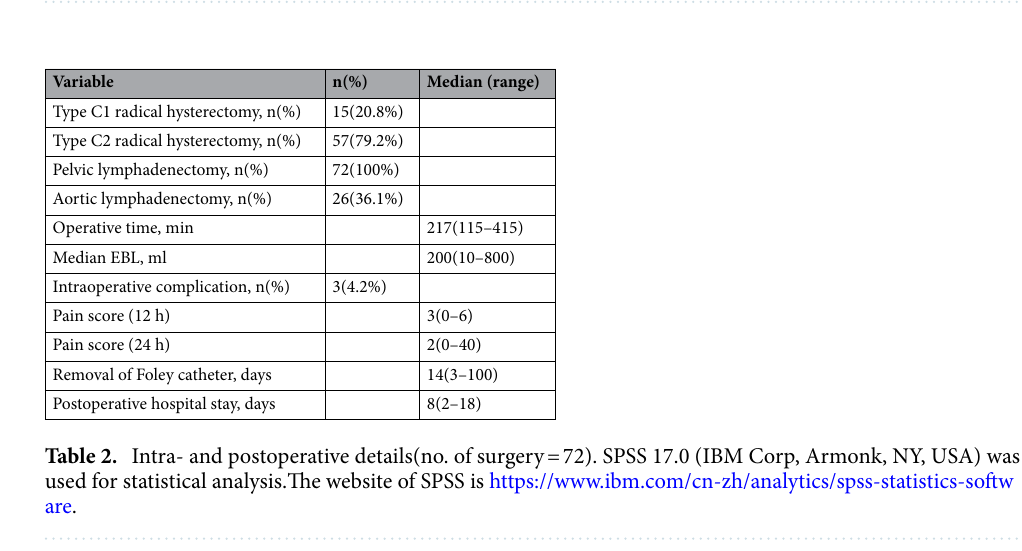
Table 1. Patients’ characteristics and staging (no. of surgery = 72). SPSS 17.0 (IBM Corp, Armonk, NY, USA) was used for statistical analysis.The website of SPSS is https:// www. ibm. com/ cn- zh/ analy tics/ spss- stati stics- softw are.